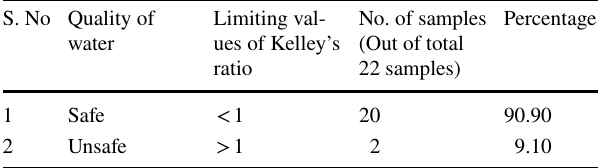
Table 9 Classification of groundwater quality based on Kelley’s ratio (Kelley